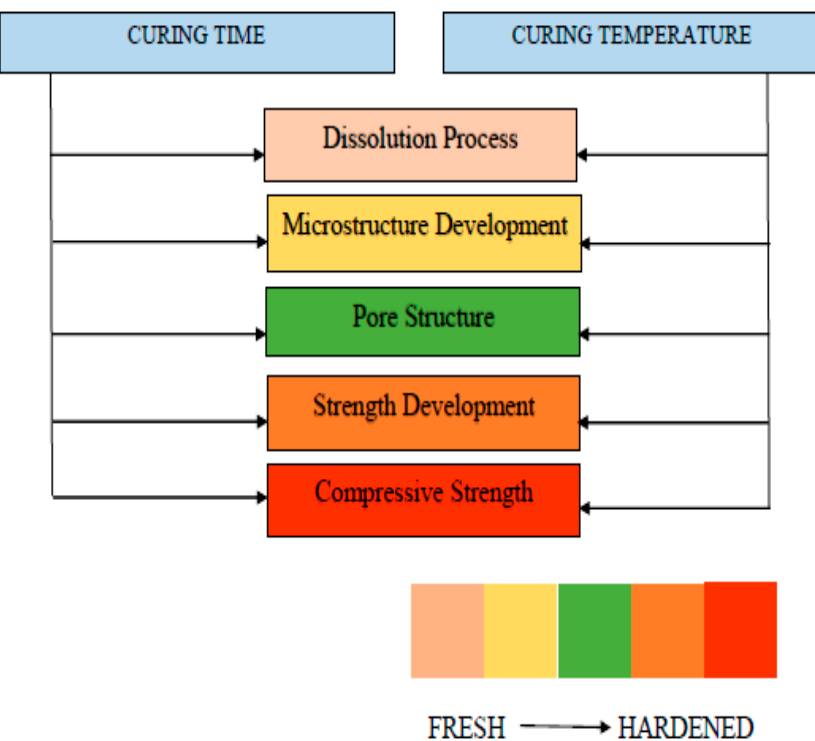
Figure 31. Fresh and hardened properties considered while determining curing conditions.